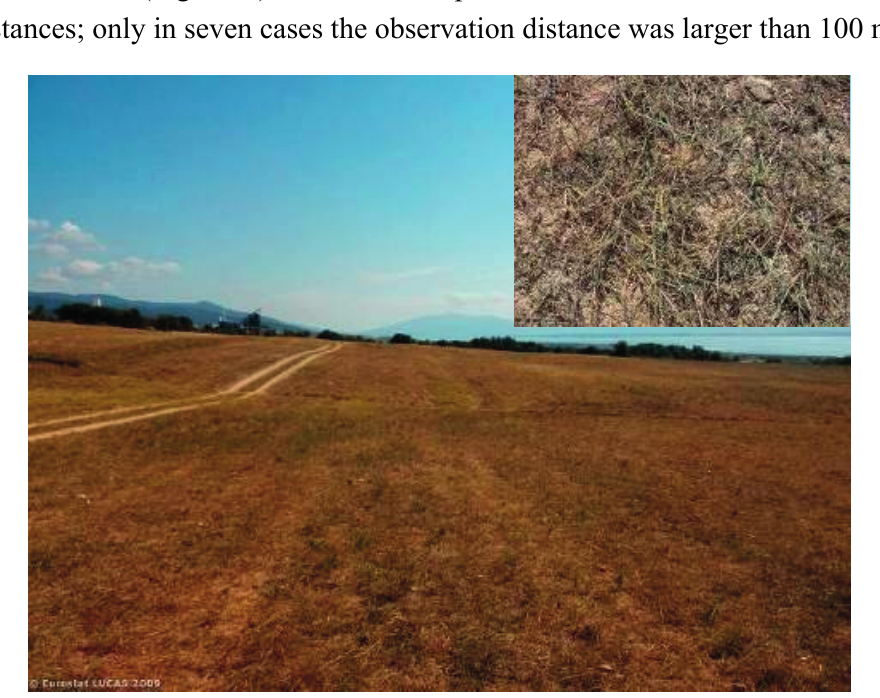
Figure 7. A case where agricultural land was classified as “Spontaneous re-vegetated surfaces” (E30) by the LUCAS surveyors, due to the fact that crop was not possible to be identified from crop residuals; in the inset: a close view of the